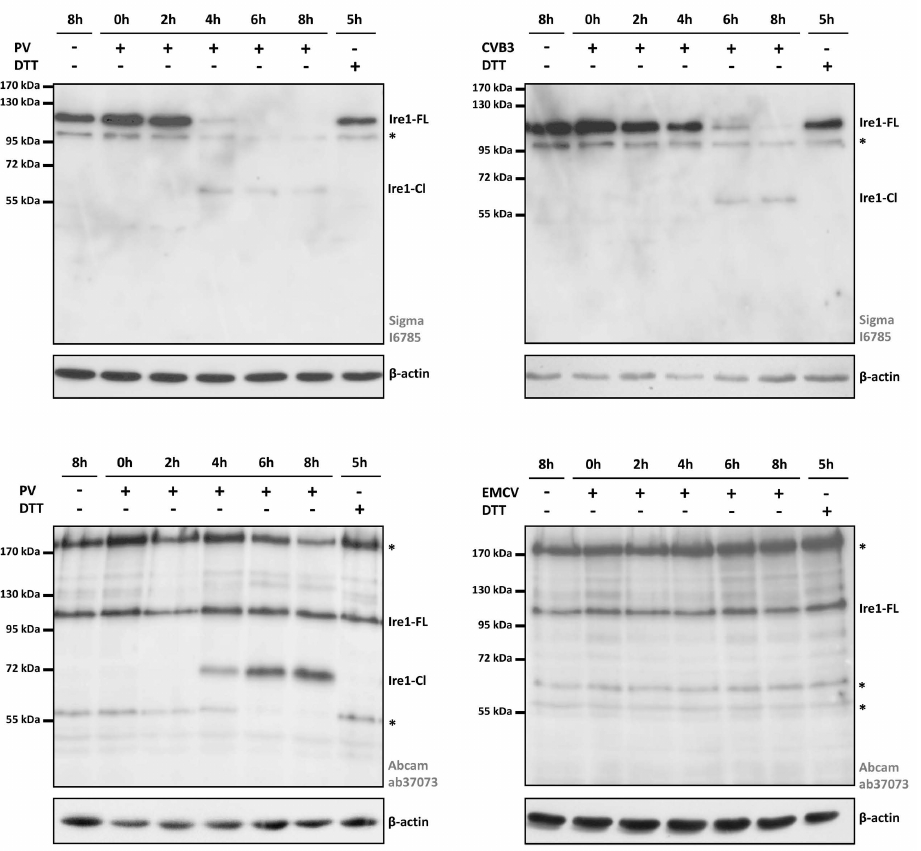
Figure 2. Total Ire1 protein levels in picornavirus-infected HeLa cells analyzed on Western blots using different antibodies. ( A ) Ire1 levels in PV-infected HeLa cells visualized using anti-Ire1 polyclonal antibodies from Sigma (#I6785). ( B ) Ire1 levels in CVB-infected HeLa cells visualized using the same antibodies (#I6785). ( C ) Ire1 levels in PV-infected HeLa cells visualized using an anti-Ire1 polyclonal antibody from Abcam (#ab37073). ( D ) Ire1 levels in EMCV-infected HeLa cells visualized on Western blots using antibodies from Abcam. Representative results of at least three independent experiments are shown. Ire1-FL—the full-length Ire1; Ire1-Cl—products of Ire1 proteolytic cleavage; *—non-specific